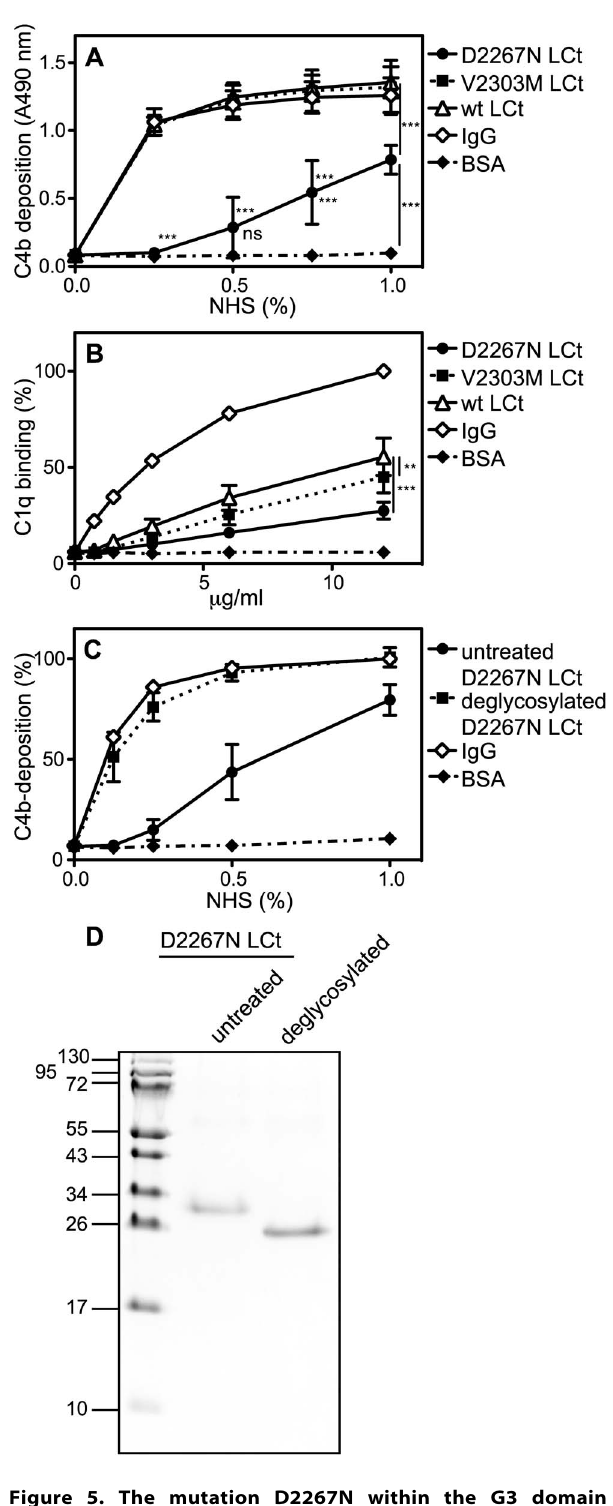
Figure 5. The mutation D2267N within the G3 domain decreases the complement activation capacity. A–B , microtiter plates were coated with aggregated IgG (positive control for classical pathway), LCt carrying the mutation D2267N or V2303M, wt LCt, and BSA (negative control). A , increasing concentrations of NHS were added and complement activation was measured by detecting deposited C4b. B , plates were incubated with purified C1q, which was then detected with specific antibodies. C , Microtiter plates were coated with untreated or N-glycosidase F-treated D2267N LCt, aggregated IgG and